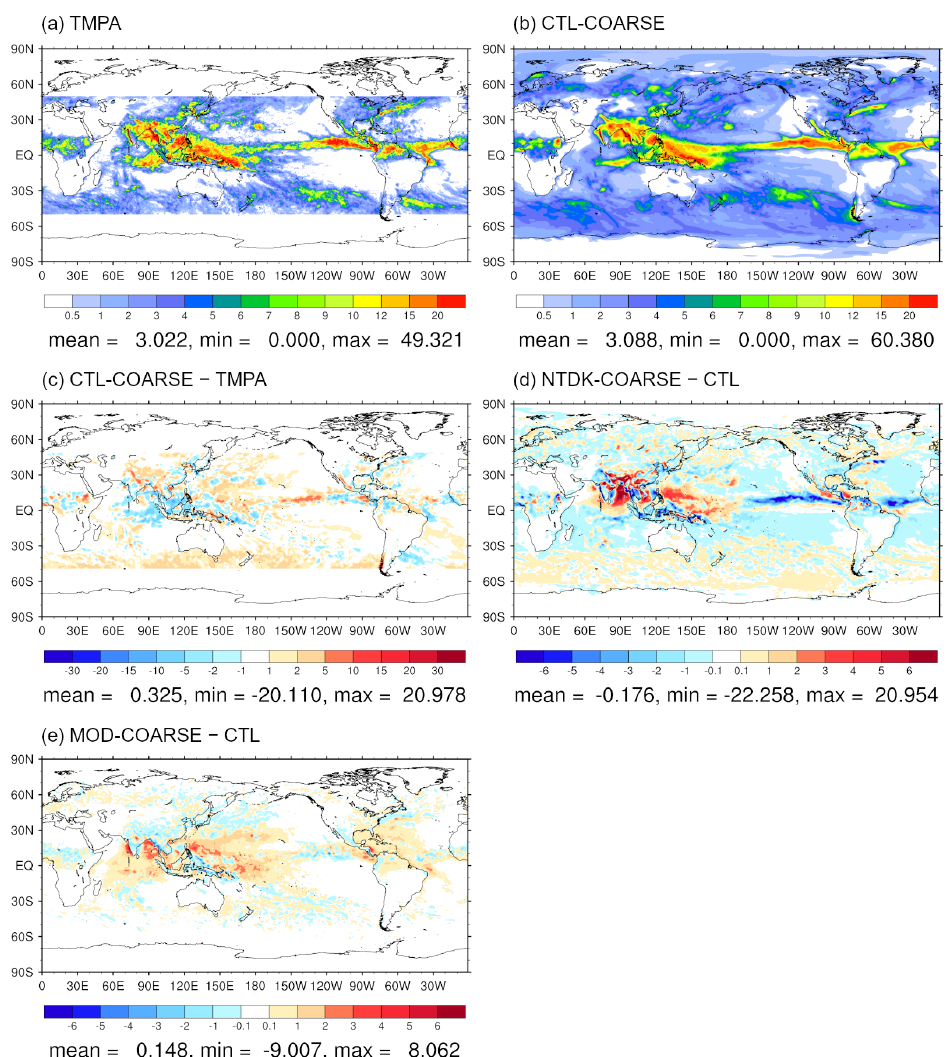
Figure 10. Global distribution of the precipitation rate (mm day − 1 ) from the ( a ) TMPA observations and ( b ) CTL-COARSE experiments averaged over the 3-day forecast period during 1–20 July 2017 and the precipitation rate differences between the ( c ) CTL-COARSE and TMPA, ( d ) NTDK-COARSE and CTL-COARSE experiments, and ( e ) MOD-COARSE and CTL-COARSE